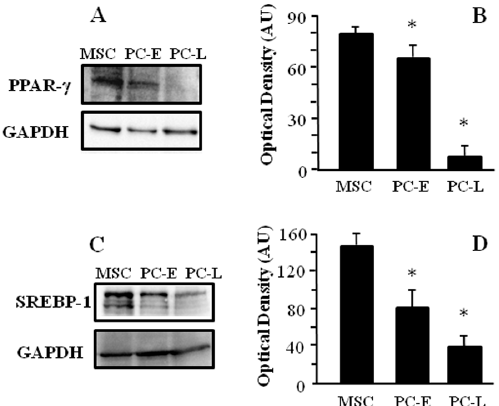
Figure 2. MSC express higher PPAR- γ and SREBP-1 levels as compared to PC-E and PC-L. MSC, PC-E and PC-L were lysed and protein samples were subjected to Western blot analyses using Glyceraldehyde 3-Phosphate Dehydrogenase (GAPDH) as a loading control. Representative panels of: PPAR- γ ( A ); and SREBP-1 ( C ) are shown. Densitometric analyses of: PPAR- γ ( B ); and SREBP-1 ( D ) relative to GAPDH in three independent experiments are presented in the graph as the mean ± s.d. expressed as Arbitrary Units (AU). PPAR- γ and SREBP-1 show down-regulation in melanoma cells undergoing progressive differentiation. * indicates p ≤ 0.05 in PC vs . MSC.